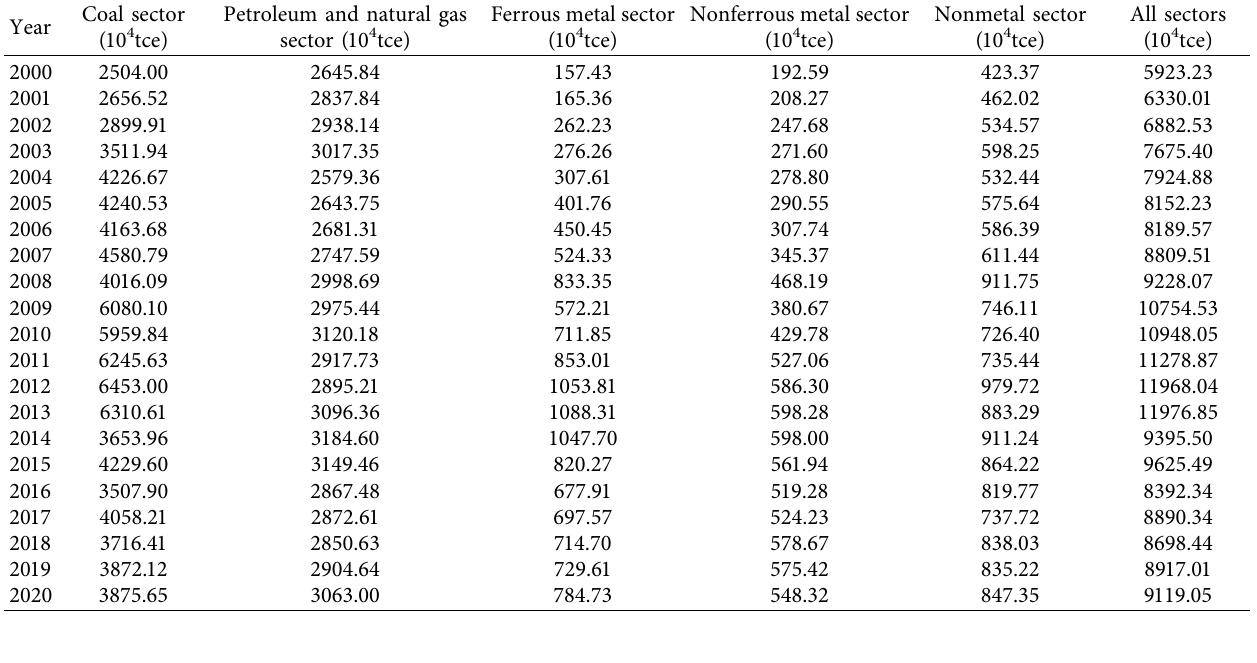
Table 6: Energy consumption of mining industry and its subsectors from 2000 to 2020.